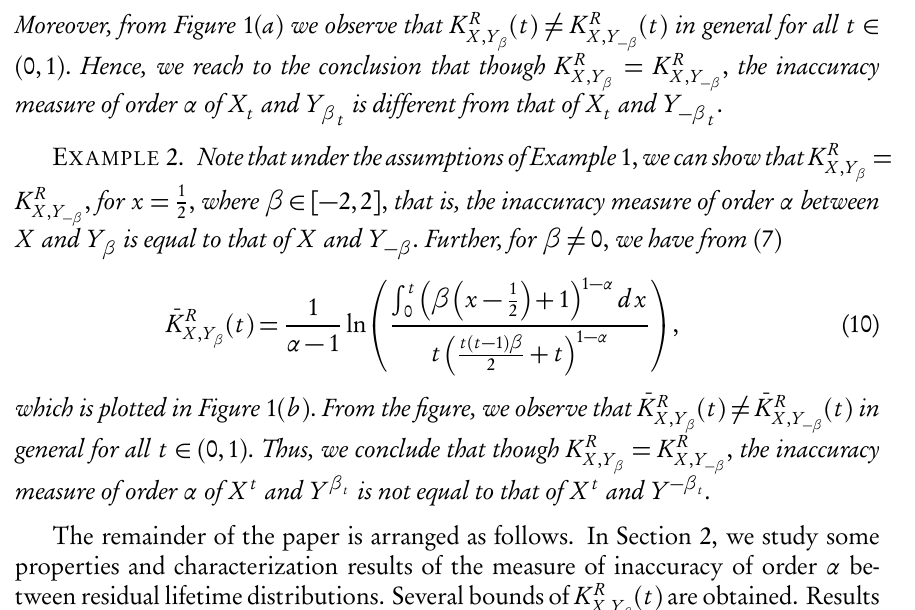
Figure 1 – Figure (a) represents the plot of the measure (9) for t ∈ ( 0,1 ) , with β = 1.7 (top line) and β = − 1.7 (bottom line), whereas Figure (b) represents the plot of the measure (10) for t ∈ ( 0,1 ) , with β = 1.7 (bottom line) and β = − 1.7 (top